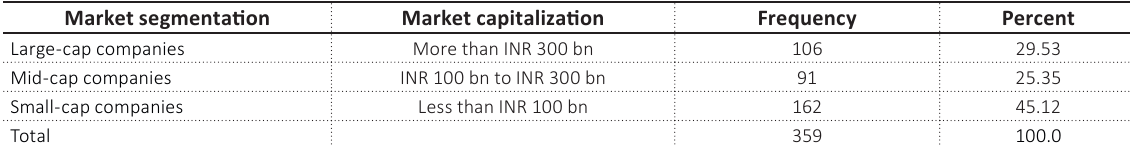
Table 1. Sample of stocks listed on the NSE according to market capitalization Market